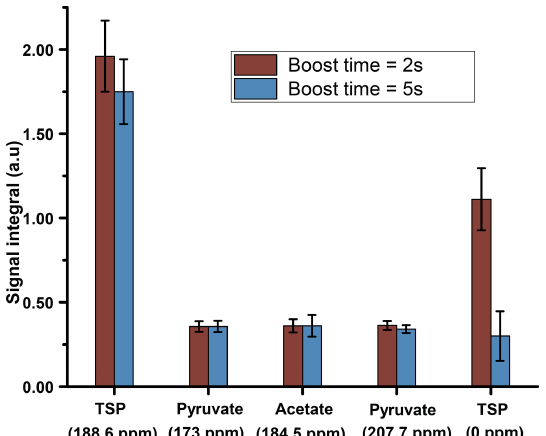
Figure 6. Plot of liquid-state hyperpolarized 13 C– { 1 H } signal in- tegral repeatability before and after optimized dissolution timings using 1.575mm ID of transfer line and D 2 O as dissolution solvent, keeping a flush and relax delay of 2.1s.